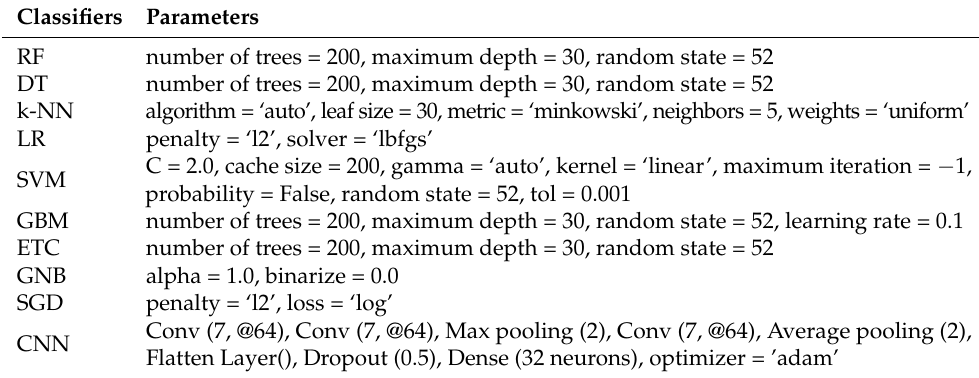
Table 1. Hyperparameter values of all models used in this research